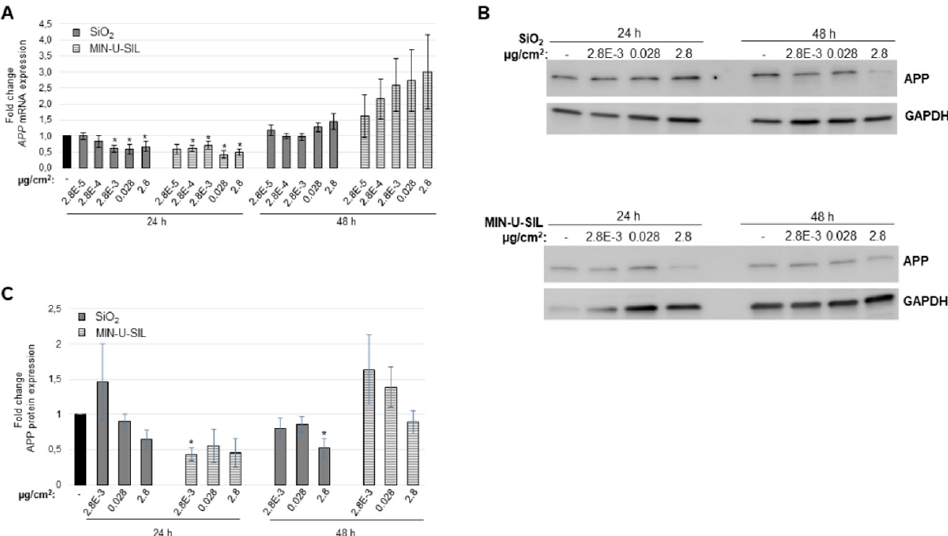
Figure 4. Expression levels of amyloid precursor protein (APP) after exposure to the two types of silica dust. Astrocytoma cells were exposed for 24 and 48 h with the indicated doses. mRNA expression was investigated by qPCR. ( A ) APP mRNA expression levels; ( B ) APP protein expression levels. Representative western blot images are shown; ( C ) Quantification of APP expression. An average from three independent experiments is shown. Values represent the mean ± standard error (SE) of two independent experiments performed in triplicate. * p < 0.05 between exposed cells and the sham-treated control. Error bars: SE.